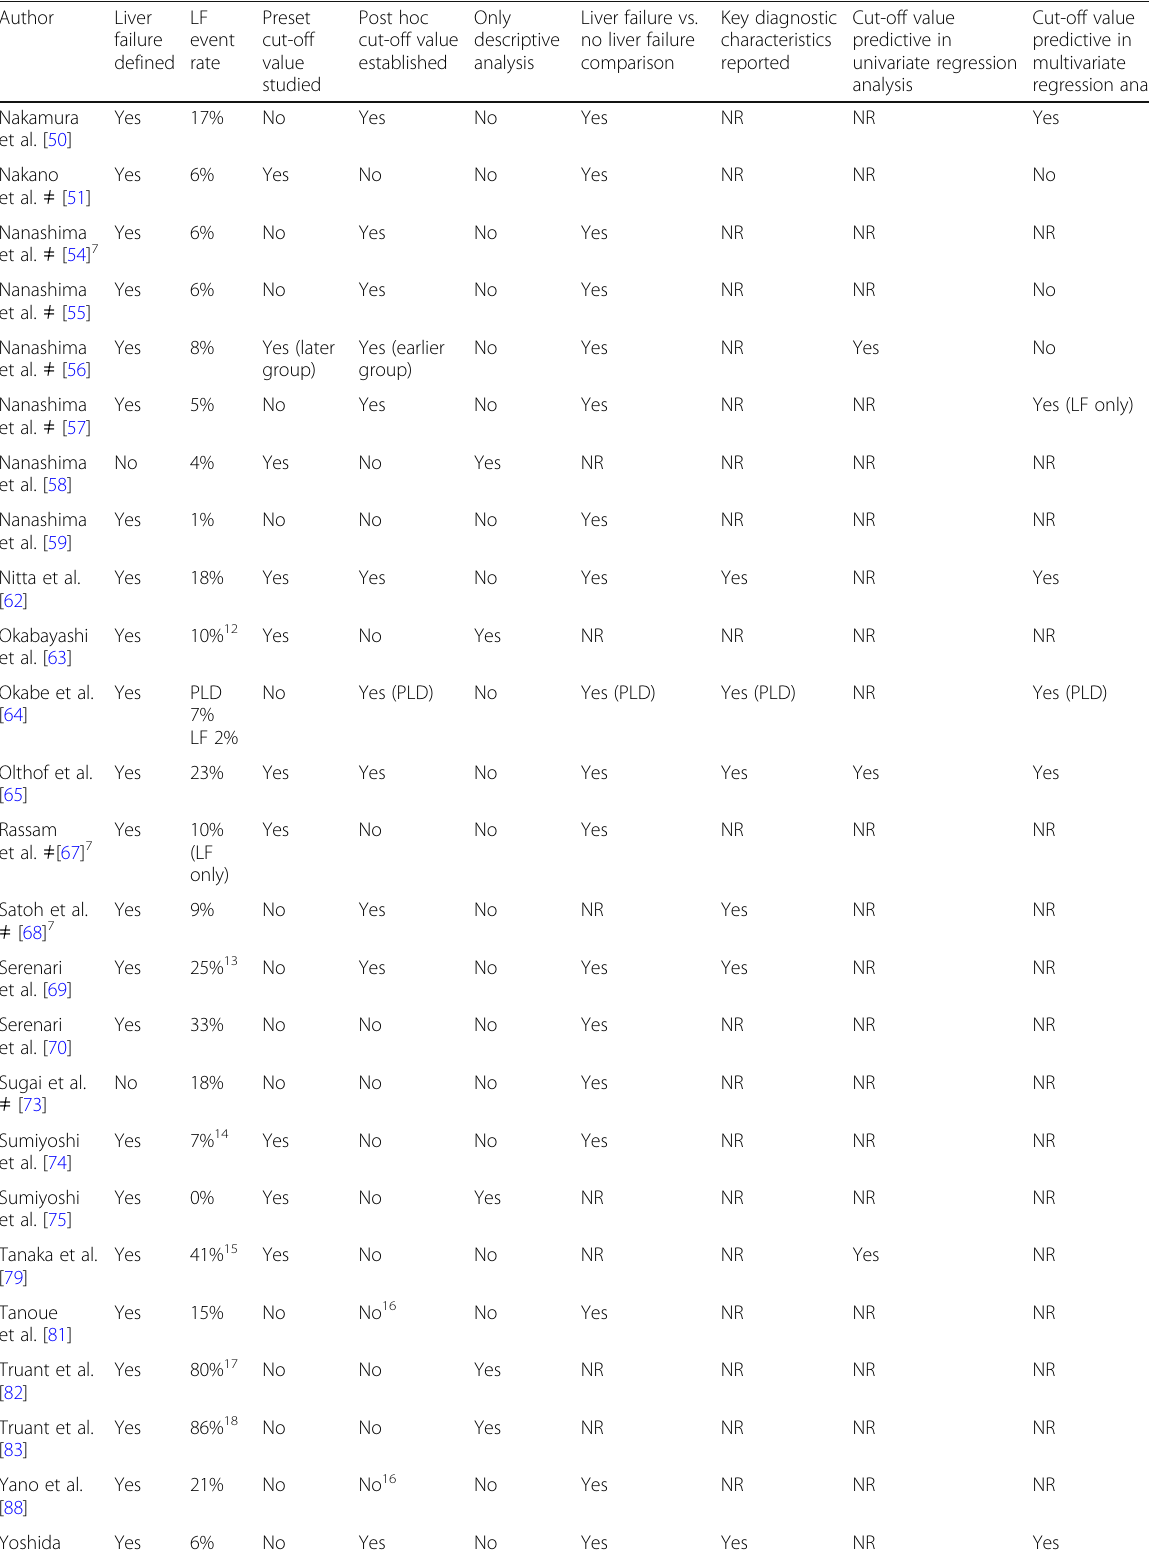
Table 3 Overview of the studies reporting on the correlation between a preoperative nuclear imaging examination and the postoperative outcome liver failure